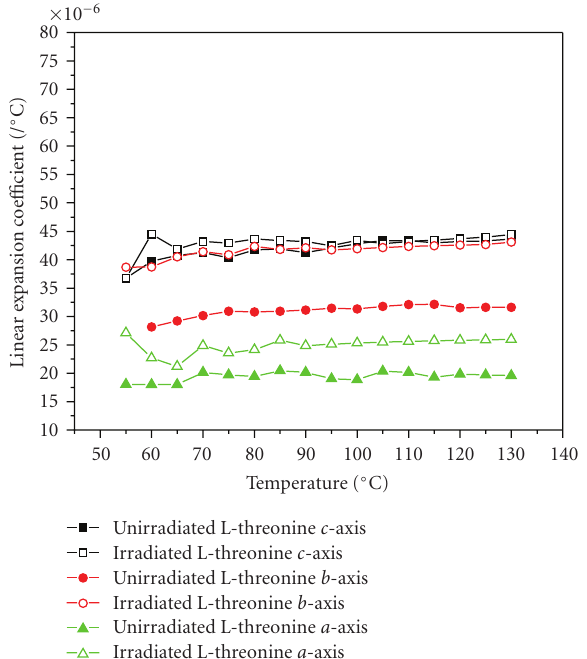
Figure 47: Coe ffi cient of linear expansion versus temperature of pure and electron-irradiated L-threonine crystal at 12 × 10 14 e/cm 2 . single crystals [108]. The increase in the conductivity lowers the energy gap and hence shifts the absorption edge towards the higher wavelength side. The results are in line with the reported works on similar studies [108–110].